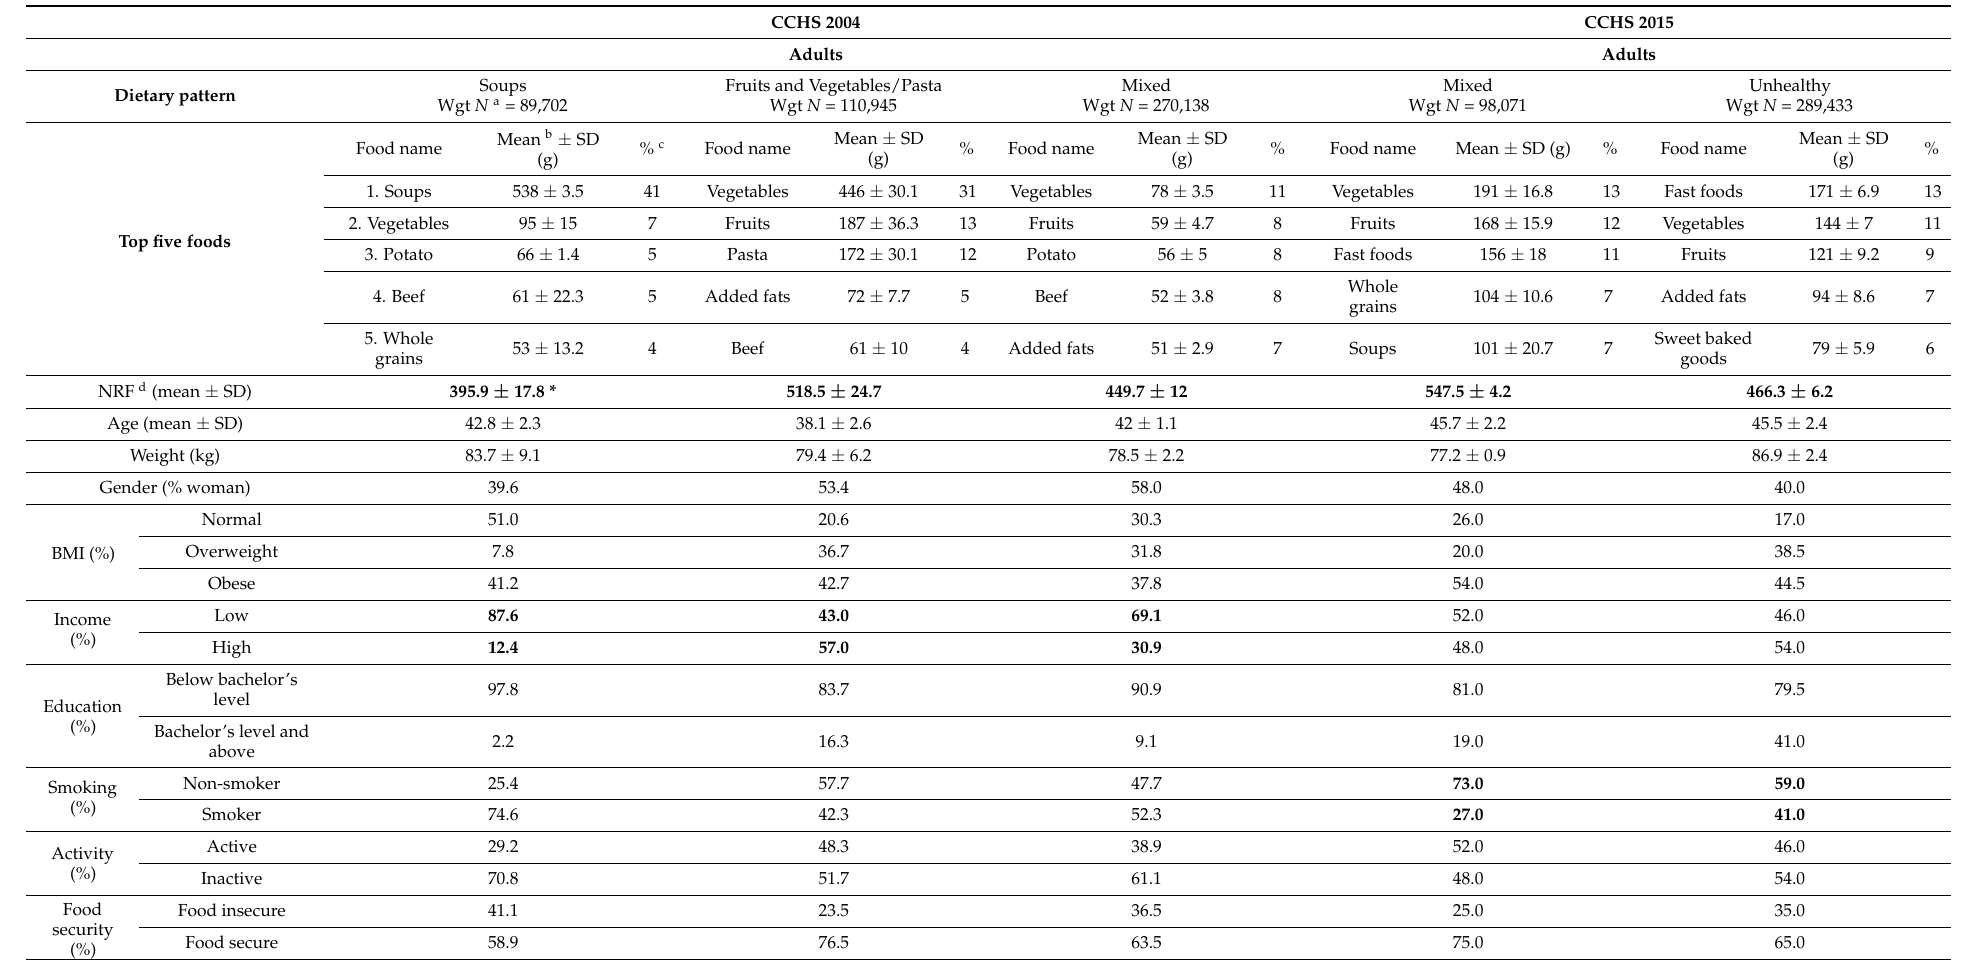
Table 1. Dietary patterns of Indigenous adults in 2004 and